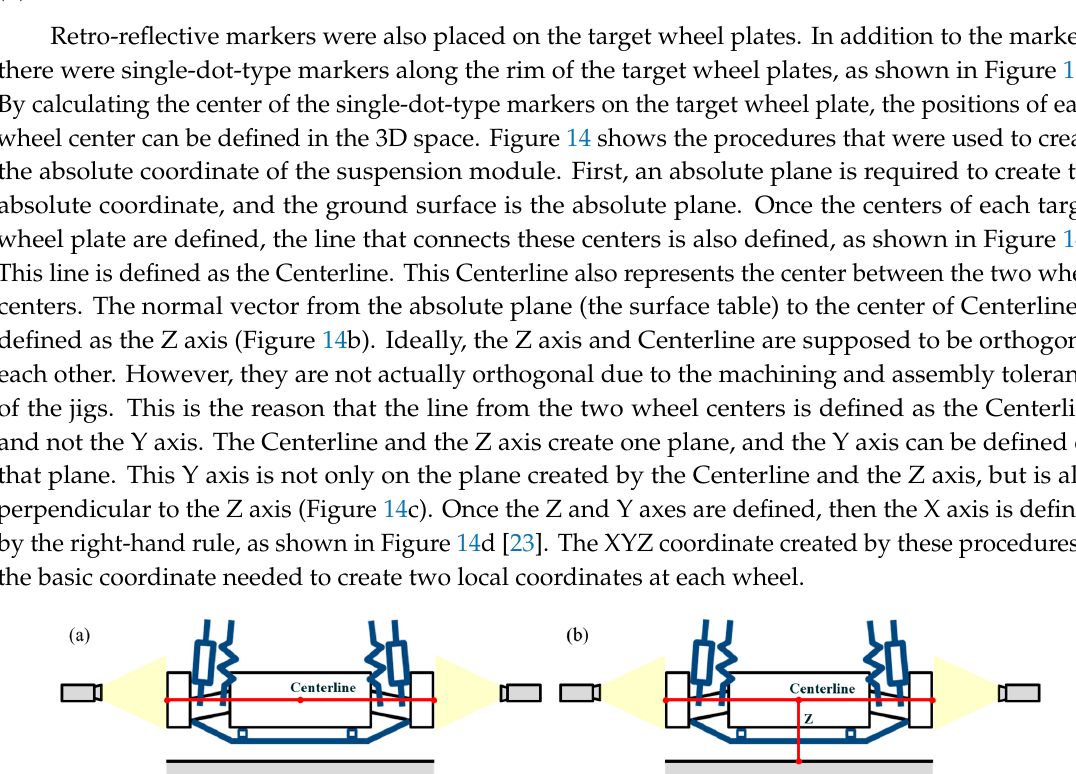
Figure 13. 3D space creation. ( a ) Markers on the suspension module and jigs. ( b ) Created 3D space using markers.